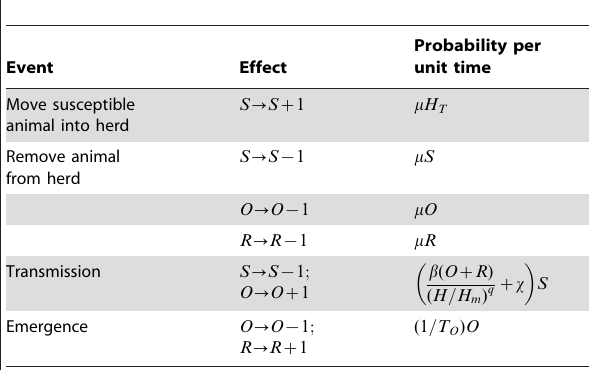
Table 4. Events defining SOR stochastic epidemic